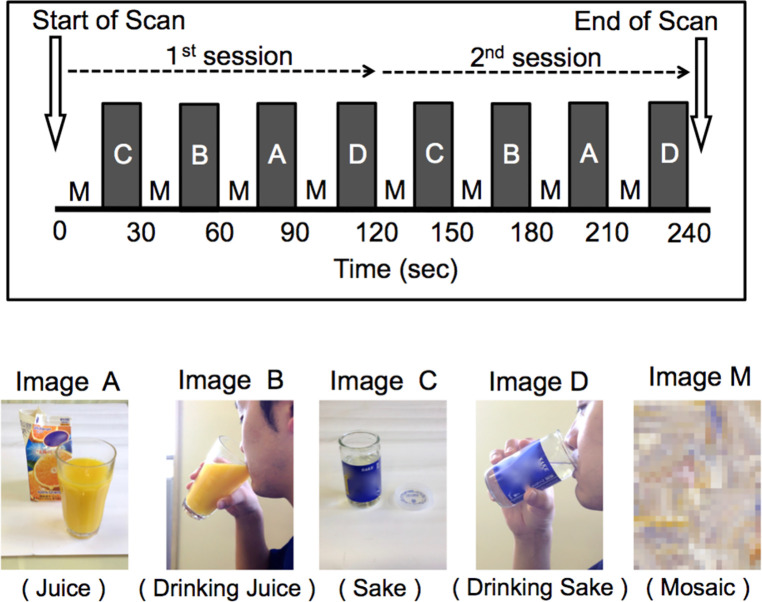
Study design and presenting images.We presented four beverage-related images (Image A, juice; Image B, drinking juice; Image C, sake; and Image D, drinking sake) and a mosaic image (Image M) to participants in a block design. Sake is rice wine. One session consisted of four rest blocks and four beverage blocks, and two sessions took a total of 240 s. Beverage images were presented in order of valence (for example, “C-B-A-D” in this figure), and each beverage image was presented twice in each fMRI session. In each MRI session, we presented the brand of each beverage in the images with permission from the copyright holder. Due to requests from the copyright holders of the juice and sake brands that we used, we obscured the beverage brands with mosaics in this report.